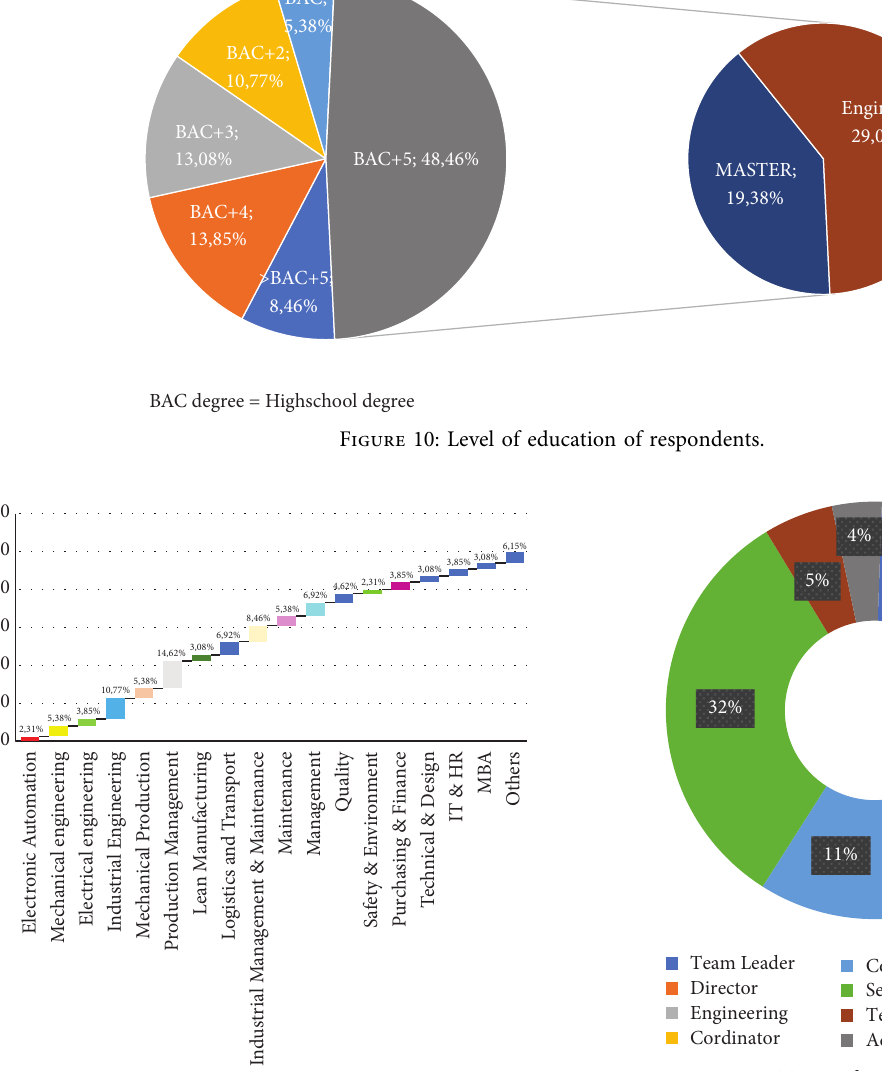
Figure 11: Most presentational types of training.